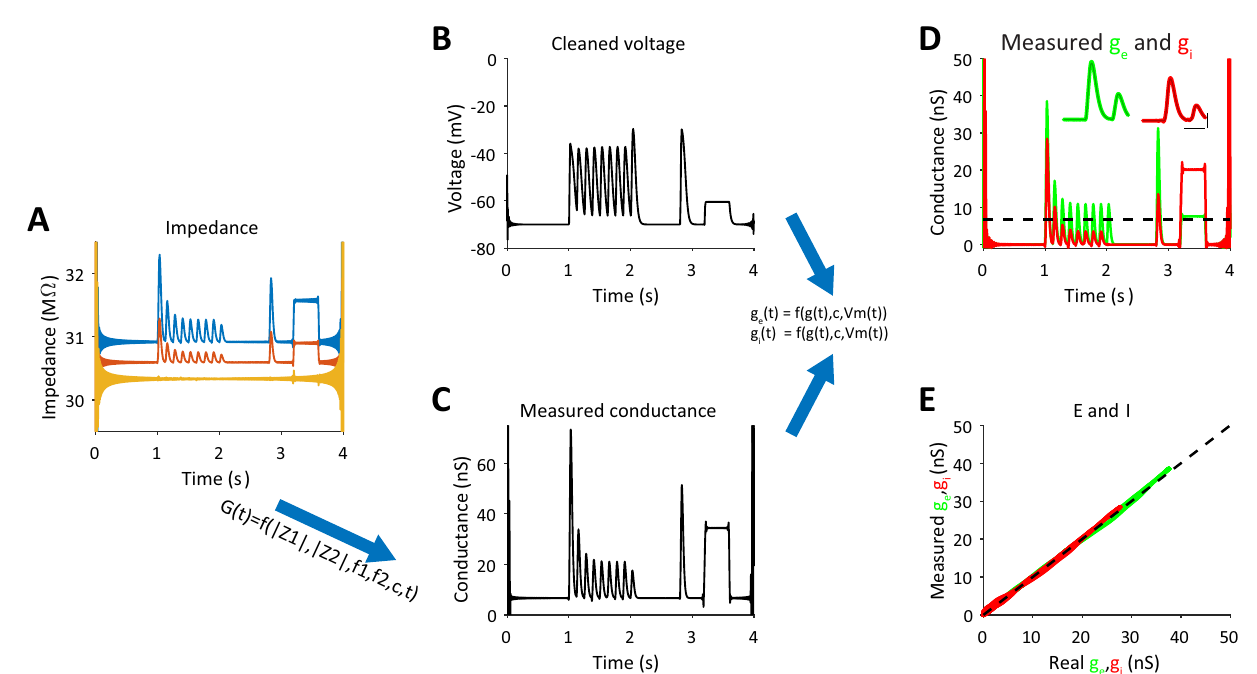
Fig 4. Measurement of g e and g i in a single trial from impedance measurements–- simulation of a point neuron. A. Absolute impedance curves for each frequency (as shown in Fig 2). B. The membrane potential after filtering out the components at the injected frequencies. C. Measured conductance and electrode resistance (shown in A) were obtained from the absolute impedance curves (Eqs 11, 12) and the estimated capacitance. D. Excitatory and inhibitory conductances were estimated from the cleaned voltage and measured conductance (Eqs 1, 2). Insets show the extended data for the first synaptic responses, superimposed with the real conductances (thin lines) (scale bars are 100ms and 10nS. E. Measured excitatory and inhibitory values plotted against real values that were used for the